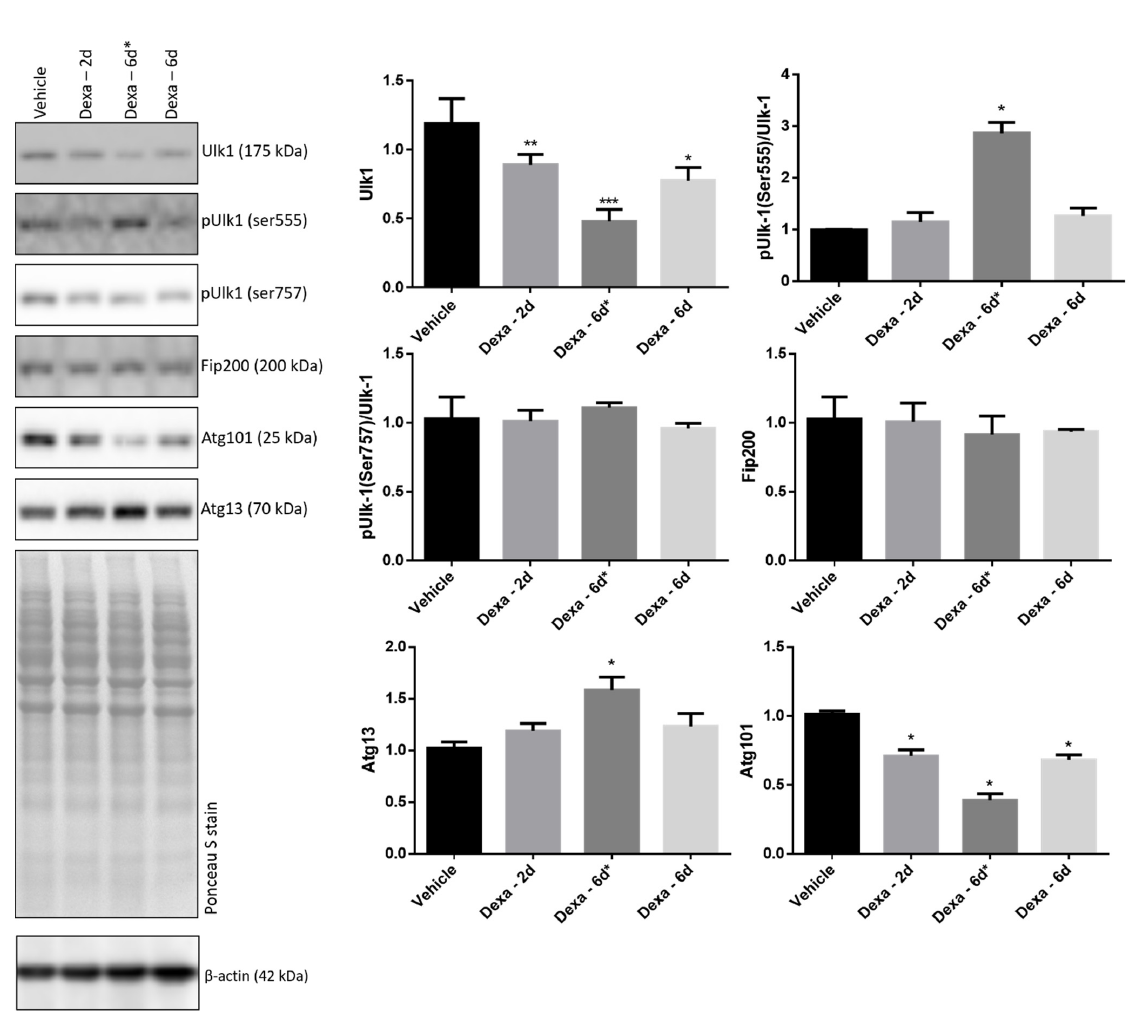
Figure 5. Downregulation of ULK1 members in Dexa-treated TMCs. Immunoblotting of Ulk-1, pUlk1(Ser555), pUlk1(Ser757), Fip200, Atg13, and Atg101 in whole cell lysates of TMCs. Normalization was performed on total proteins (Ponceau S stain). * p < 0.0001, ** p < 0.009, *** p < 0.001. A representative experiment of three independent observations is reported ( n = 3); one-way ANOVA followed by Tukey’s post hoc significance test.